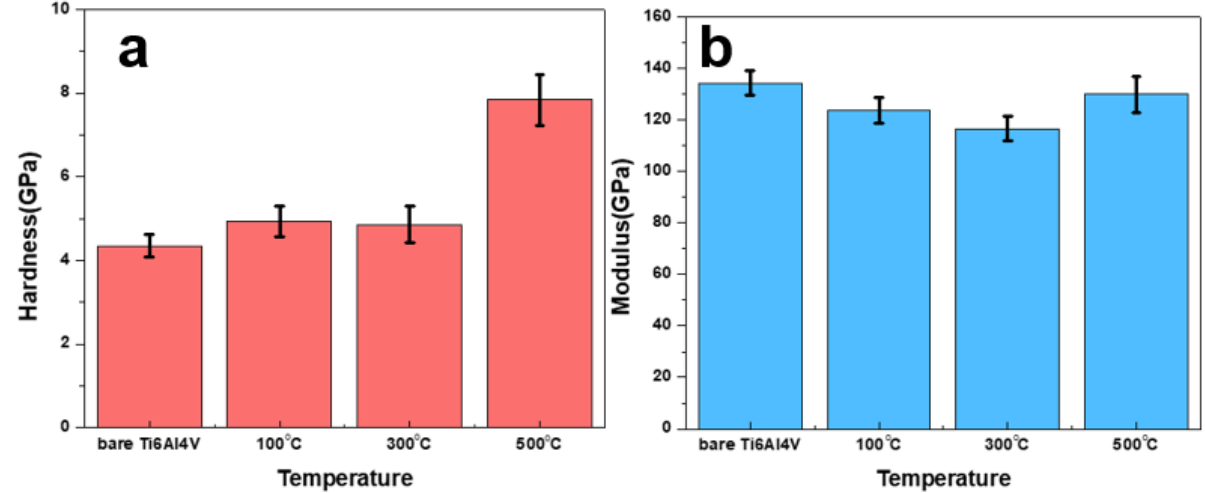
Figure 5. ( a ) Hardness and ( b ) elastic modulus of bare Ti6Al4V and inorganic thermal oxide coatings formed at 100 °C, 300 °C, and 500 °C.